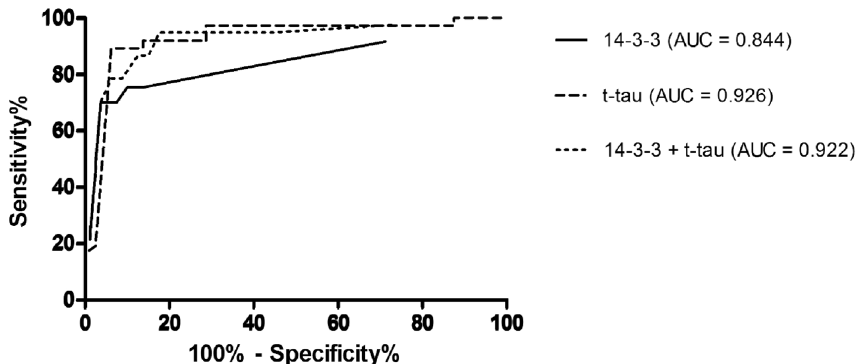
Figure 5. ROC diagrams of protein 14–3-3 positivity, CI 0.753 to 0.934 (solid line), t-tau values higher than 1200 pg/ml, CI 0.868 to 0.984 (dashed line), and the combination of protein 14–3-3 positivity and t-tau values higher than 1200 pg/ml, CI 0.861 to 0.983 (dotted line) in prion vs. non- prion disease cases. t-tau, total tau; AUC, area under the curve; CI, 95% confidence